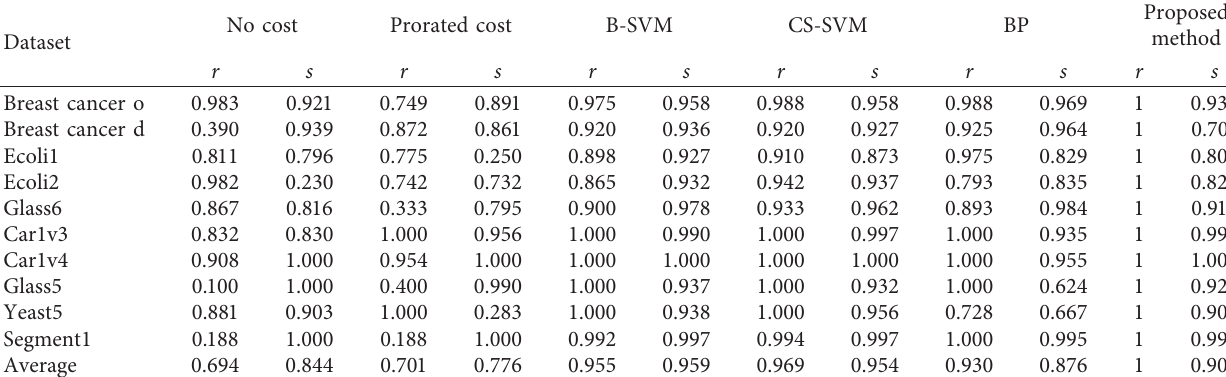
Table 3: Recall and specificity (represented by r and s ,